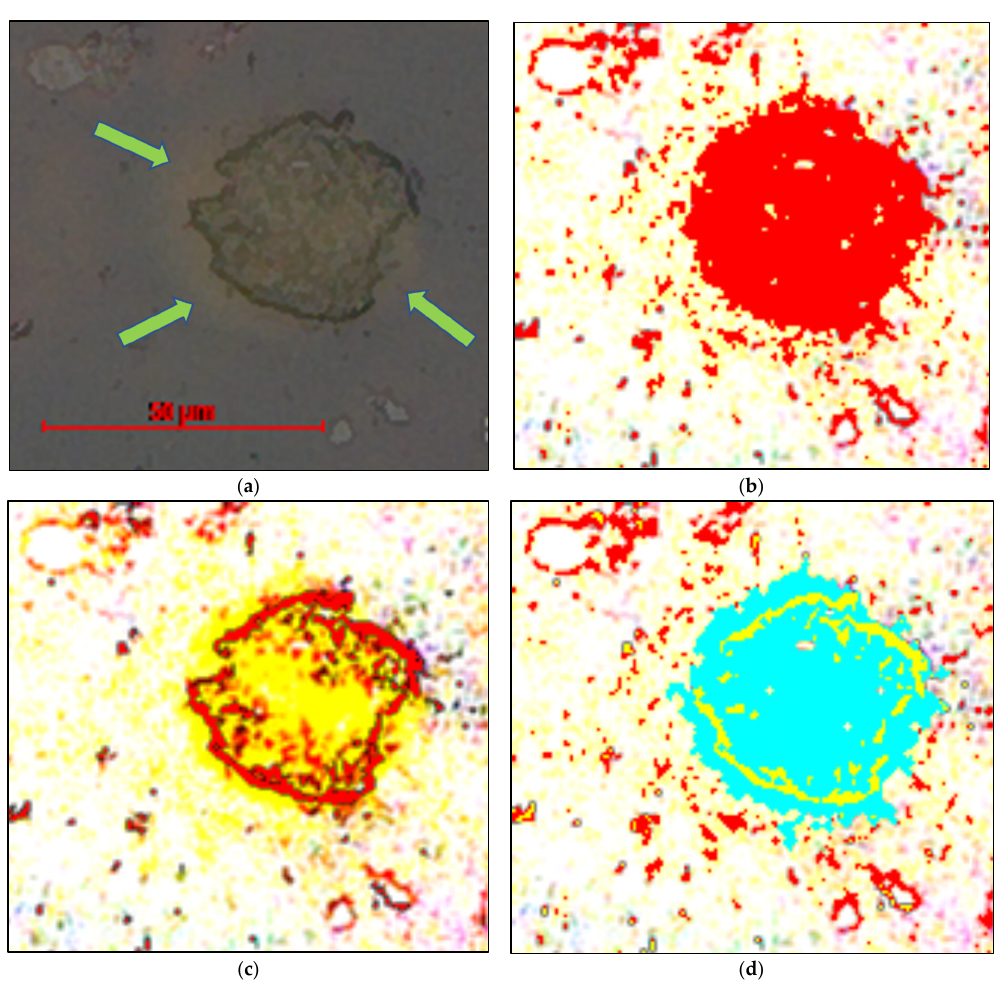
Figure 11. Thresholding of a particle surrounded by a shade: ( a ) original image, green arrows show the surrounding shade; ( b ) mineral thresholding; ( c ) border thresholding; ( d ) “Threshold” view, showing border as yellow.